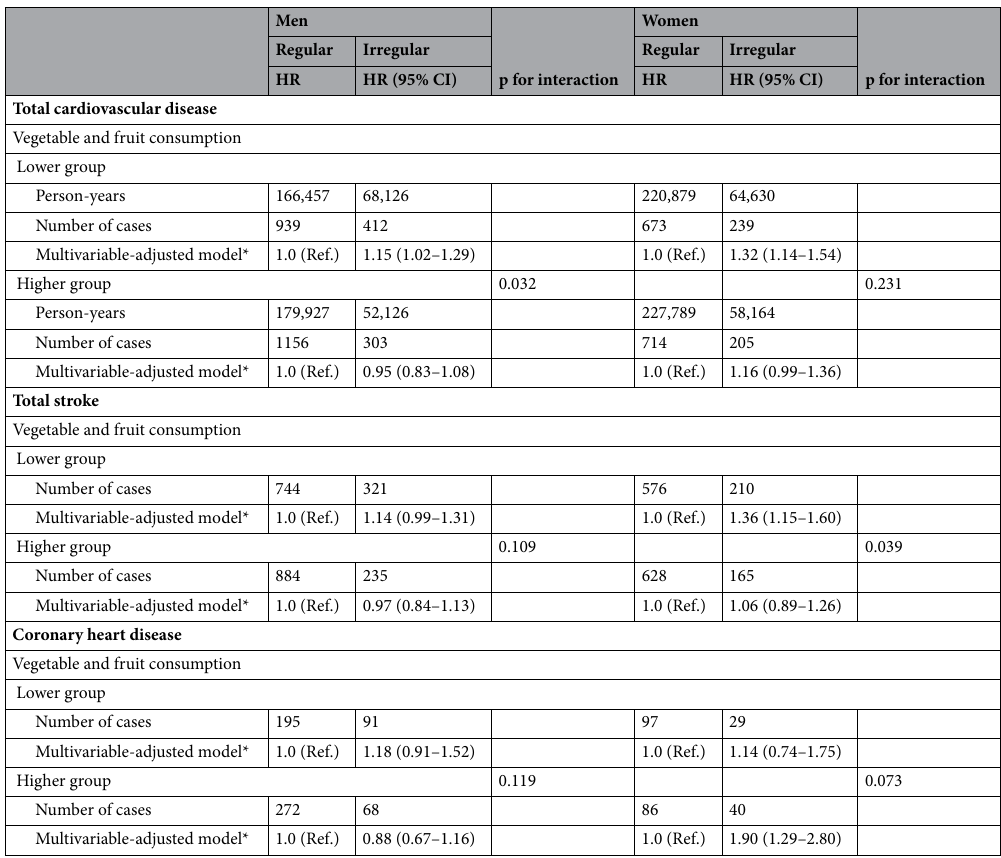
Table 3. Hazard ratios for incident cardiovascular diseases according to self-reported irregular daily routine: stratified analysis according to vegetable and fruit consumption. *Adjusted by age, study area, quartile of BMI, living arrangement, alcohol intake, cigarette smoking status, perceived mental stress, working hours, job type, frequency of eating breakfast, sleep duration, quartile of METs, energy intake, energy-adjusted dietary intakes of meat, fish, and sodium. HR hazard ratio, CI confidence interval, BMI body mass index, MET metabolic equivalent